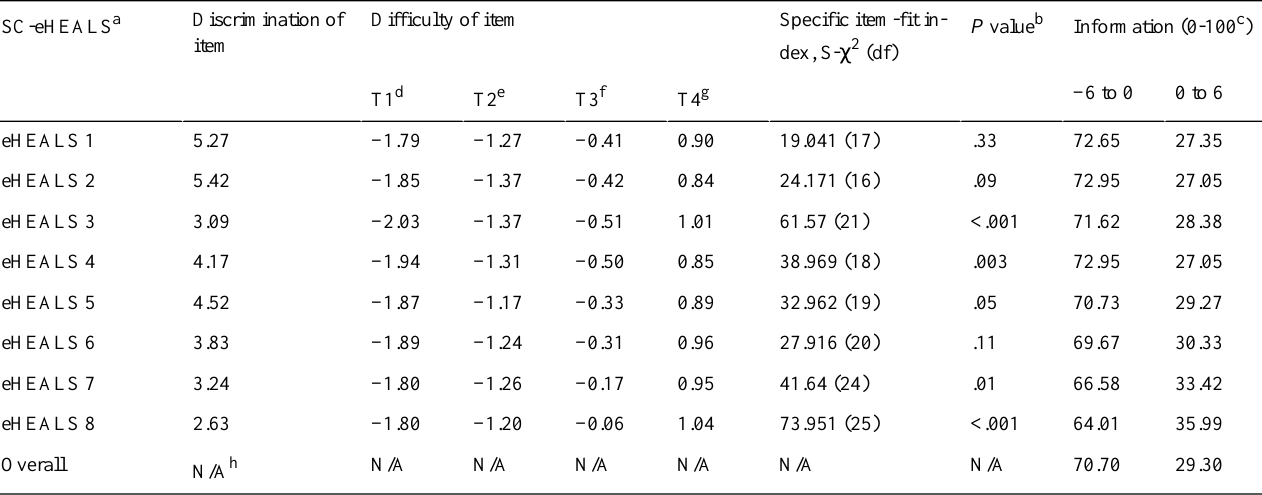
Table 6. The result of item response theory analysis of the simplified Chinese eHealth literacy